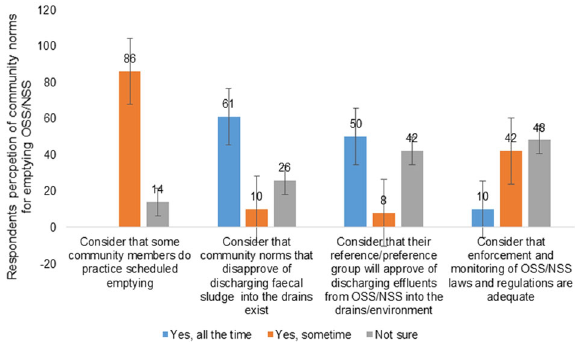
Fig. 6 Respondents ’ perception of community norms for emptying